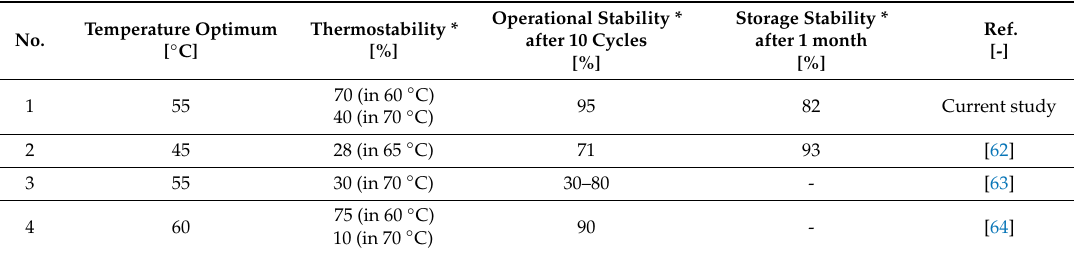
Table 9. Comparison of selected features of the invertase immobilized in gelatin-based carrier developed in the current study with other literature